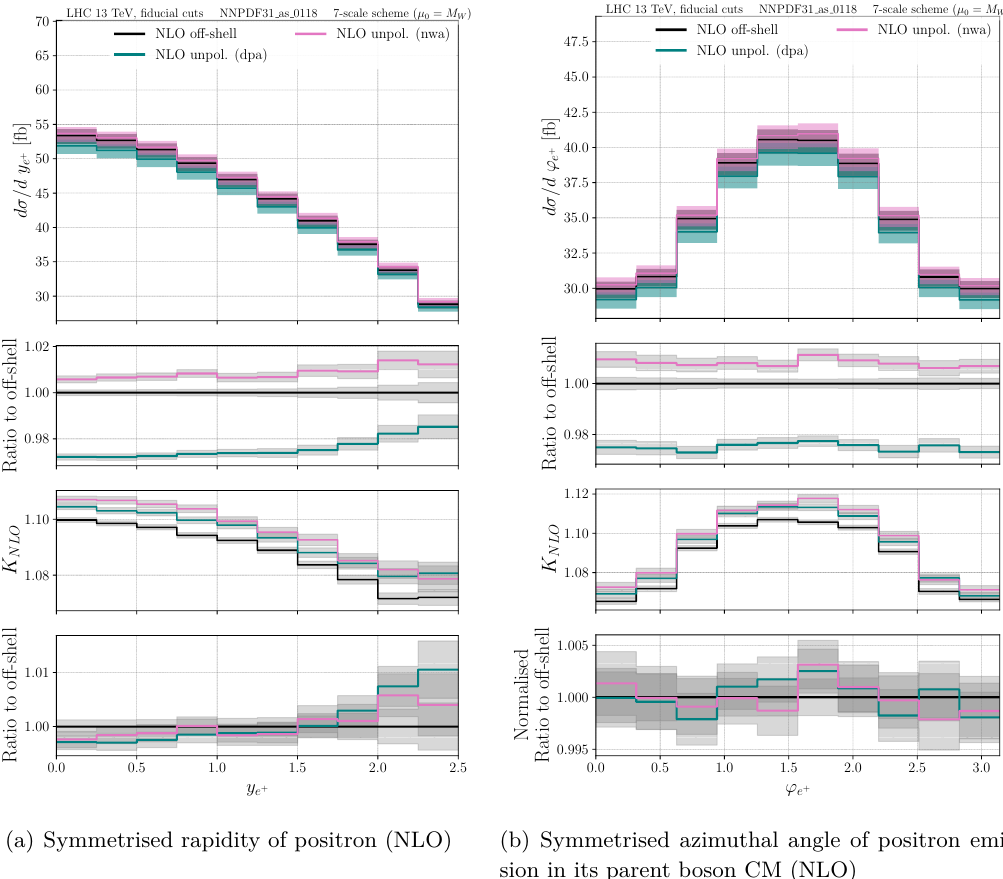
Figure 10 . Comparison between off-shell calculation, DPA, and NWA for selected distributions. Top three panes have the same structure as in figure 2; the bottom plot shows the ratio distributions to off-shell calculation normalised according to integrated cross-section